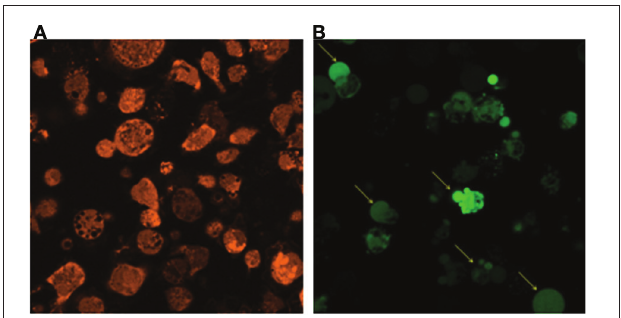
FIGURE 5 | TSB medium does not support macrophage survival. (A) Primary thioglycollate-elicited peritoneal macrophages isolated from C57BL/6 mice were stained with 5 μ M CellTracker Orange (orange) and incubated in RPMI 1640supplemented with 10% FBS for 24h at 37 ◦ C. (B) Primary macrophages isolated from GFP transgenic mice were incubated in TSB supplemented with 0.5% glucose and 3% NaCl for 24h at 37 ◦ C. Arrows indicate apoptotic